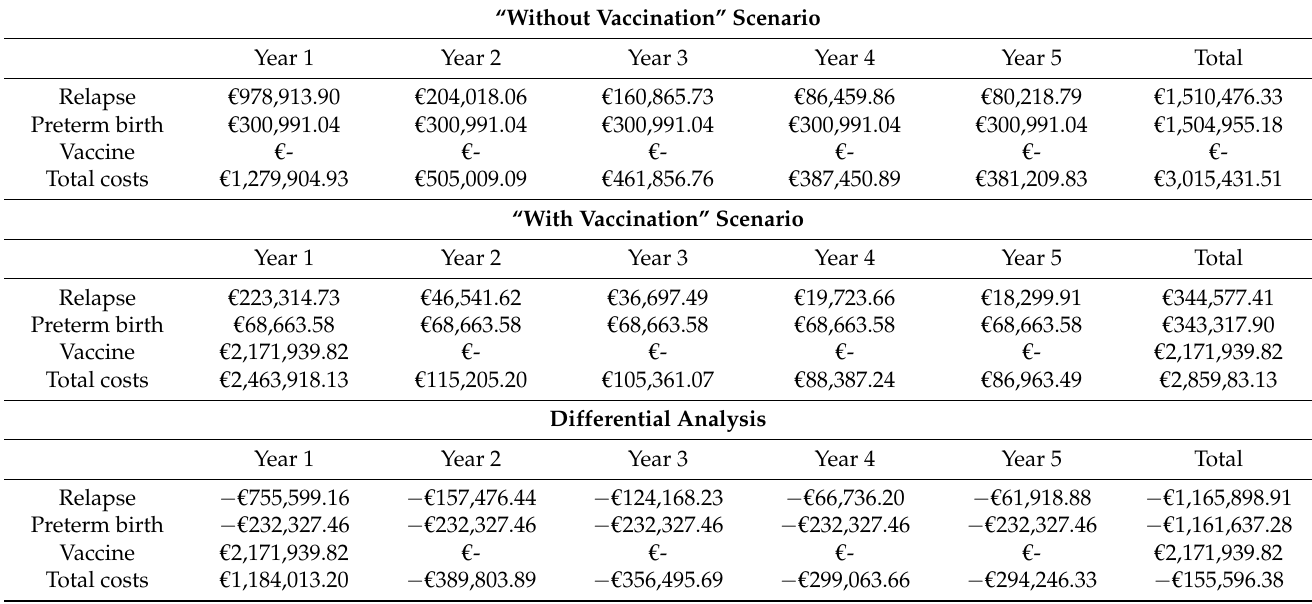
Table 9. Absorption of NHS resources in the “without vaccination” scenario, “with vaccination” scenario, and differential